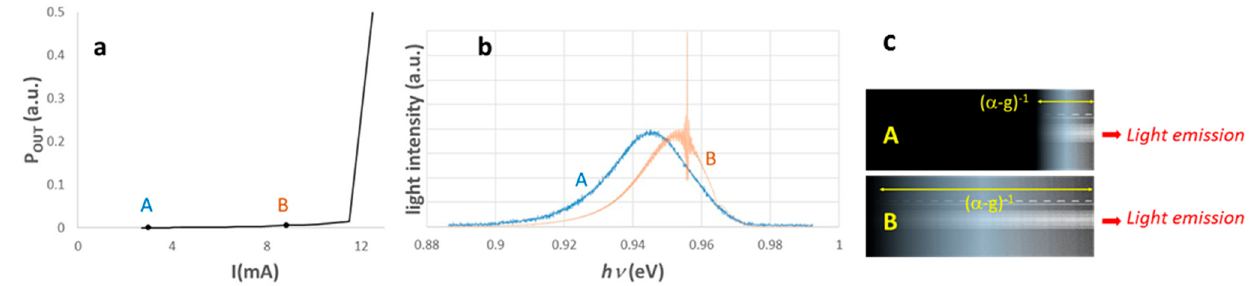
Figure 1. ( a ) Power-current curve of a DFB laser emitting at 1300 nm; ( b ) normalized spectra measured at 3 mA (A) and 9 mA (B) in the sub-threshold range; ( c ) graphical representation of cases A and B based on a real TEM cross-sectional image of a MQW DFB laser diode. In case A the inner part of the optical cavity does not contribute to the measured light emission. In case B the periodic grating is involved enough to cause the interference peak observed in the spectrum.